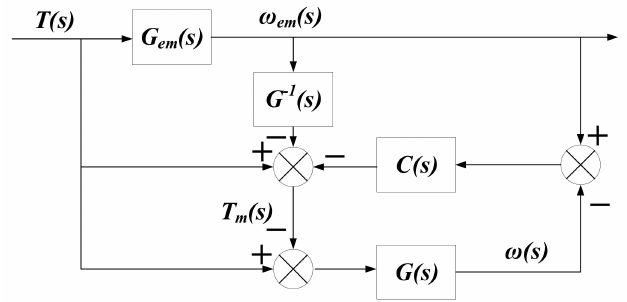
Figure 21. Forward speed tracking algorithm with